Question: Does the plotted quantity increase or decrease?
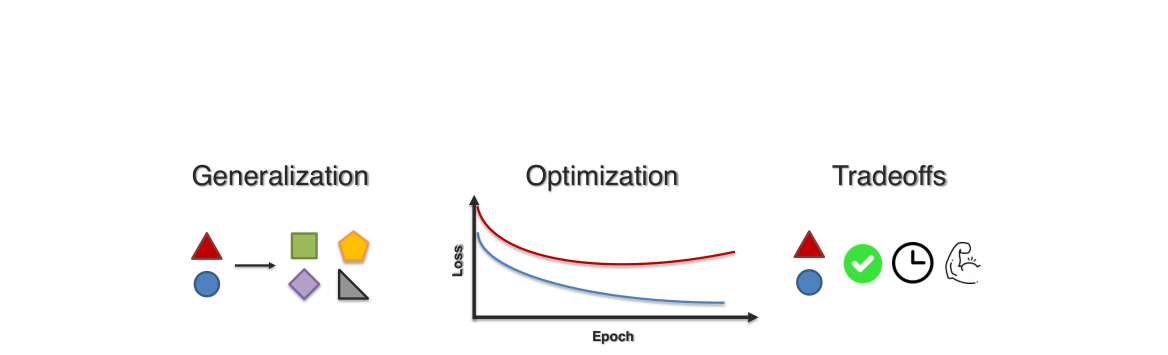
Answer: increasing